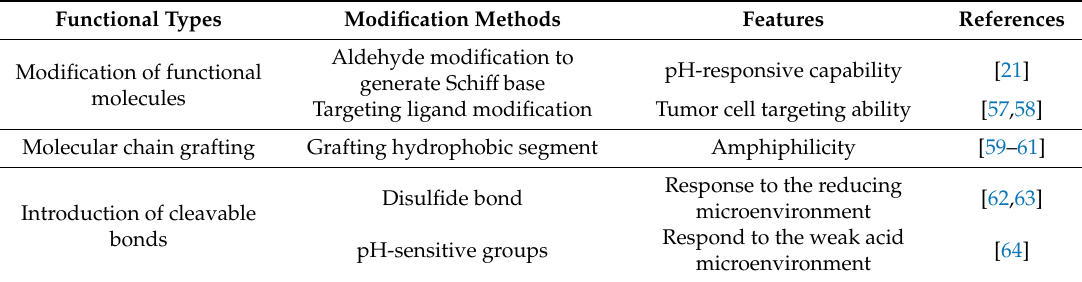
Table 1. The commonly used functionalized types of polysaccharide